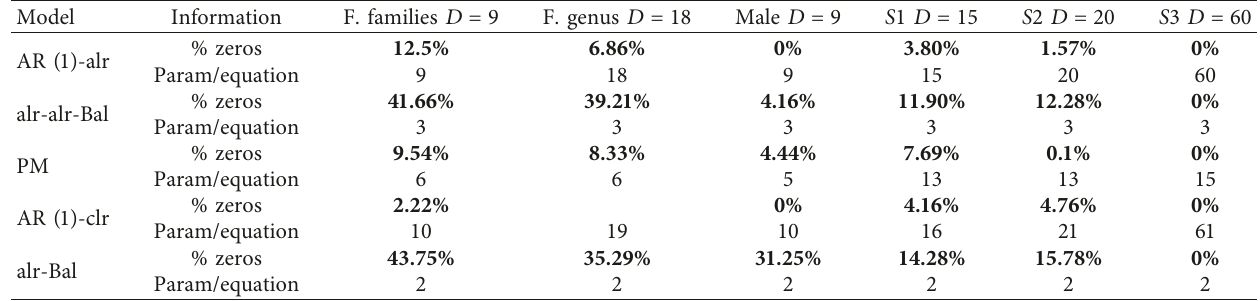
Table 4: Percentage of credible intervals that do not contain zero and the number of parameters in each equation of the model for all databases. S 1, S 2, and S 3 denote the first, second, and third simulations. Note that the AR(1)-clr model does not achieve convergence in the F. genus dataset.